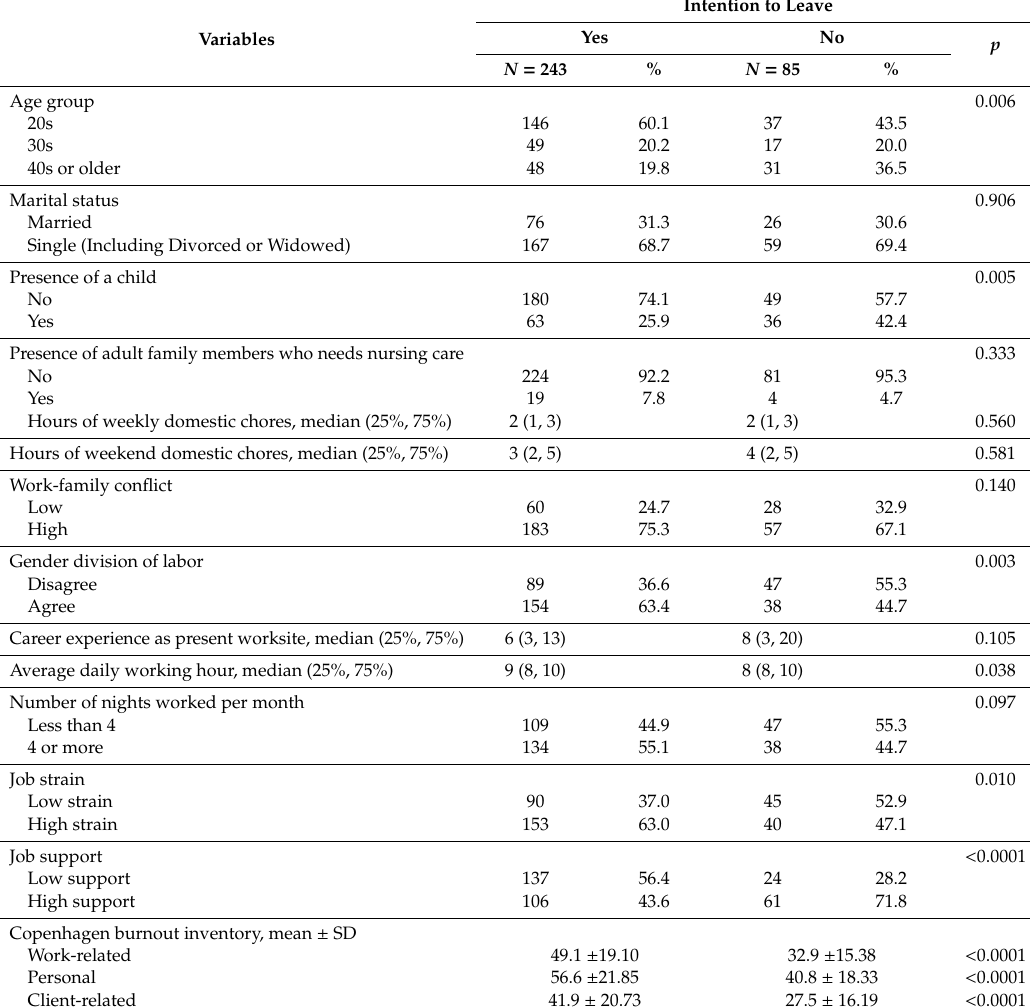
Table 2. Variables associated with “intention to leave”.